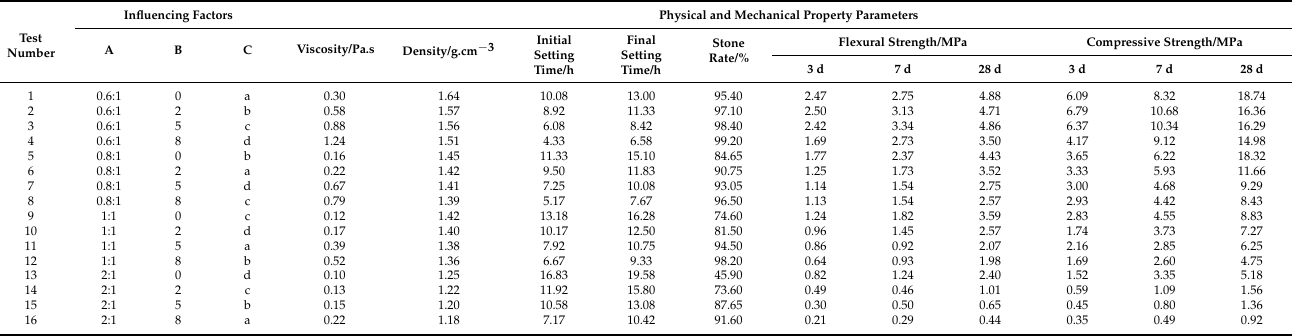
Table 5. Orthogonal test results of cement grout.